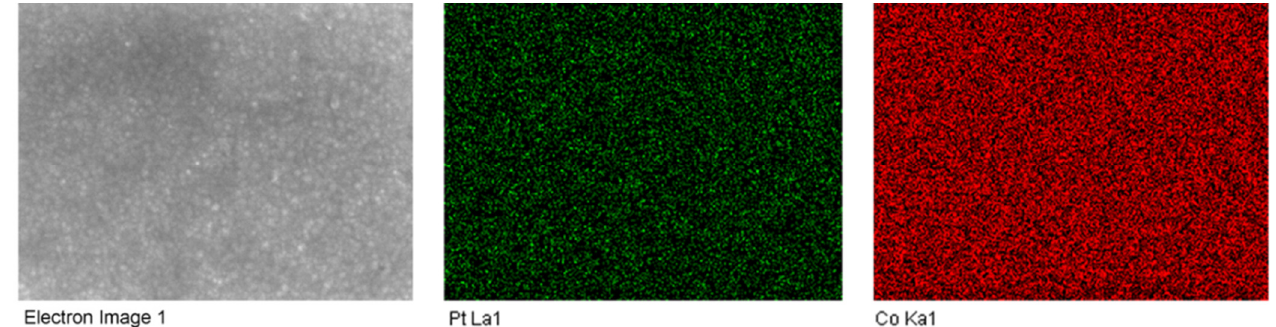
Figure 4. Elemental mapping of CoPt sample prepared at pH = 5 in the presence of saccharin.